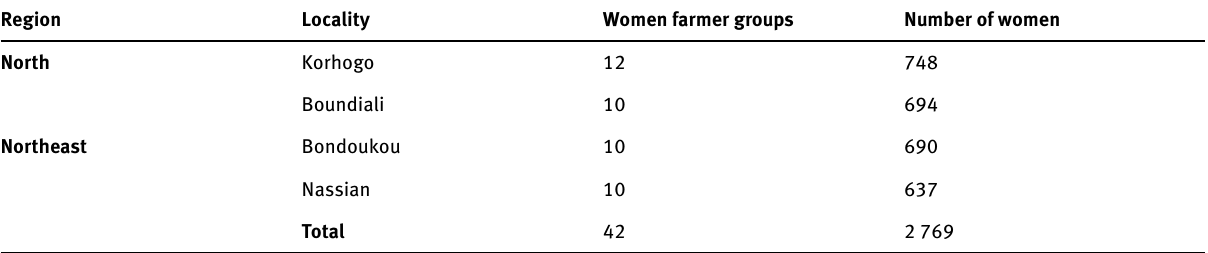
Table 1 : Number of women farmer groups engaged in OFSP on-farm demonstration per localities